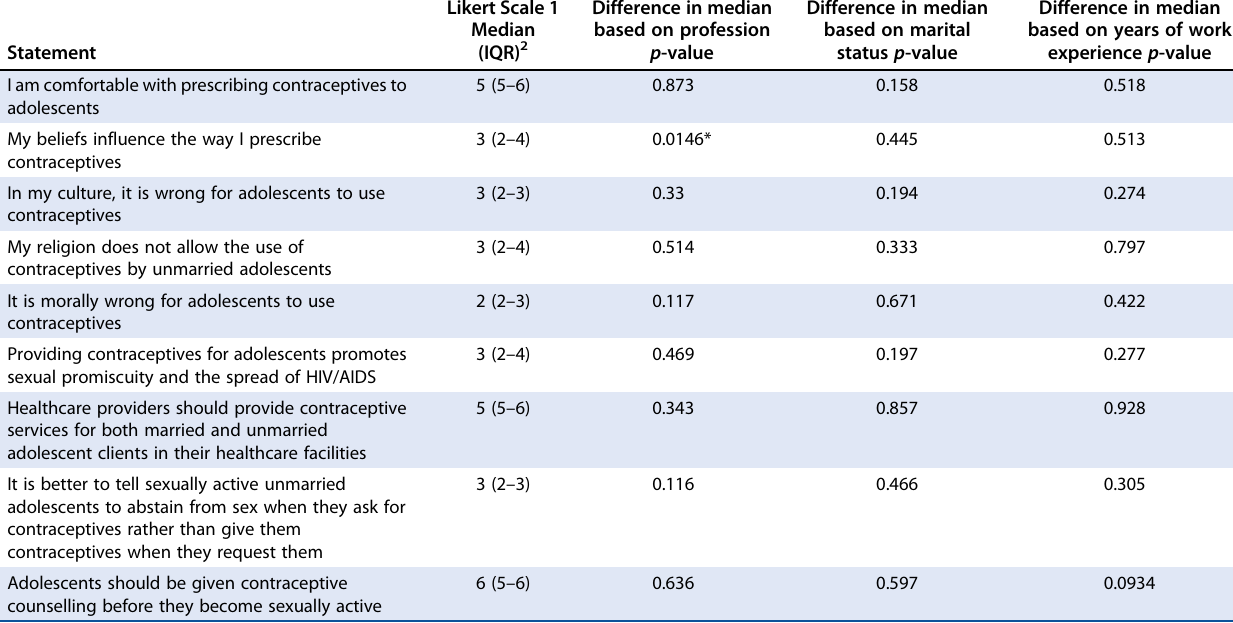
Table 3: Healthcare providers ’ attitude towards adolescents ’ contraceptive use in Mahalapye, Botswana, November – 2016